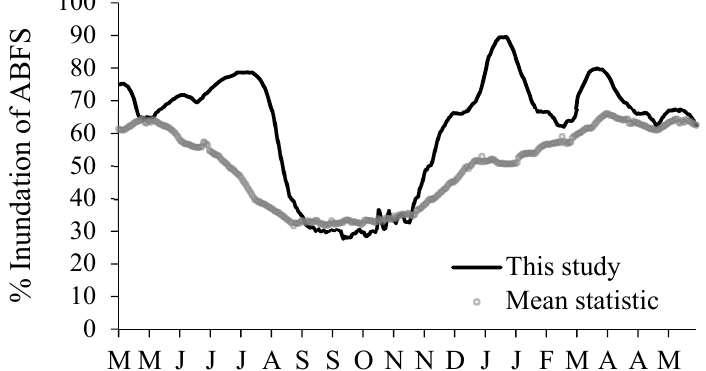
Figure 9. Estimated percent inundation of the Atchafalaya Basin Floodway System (ABFS) for this period of study compared to daily means calculated from data for water years 1996–2015. Data was obtained from the U.S. Geological Survey (USGS) National Water Information System Web Interface (http://waterdata.usgs.gov/nwis).